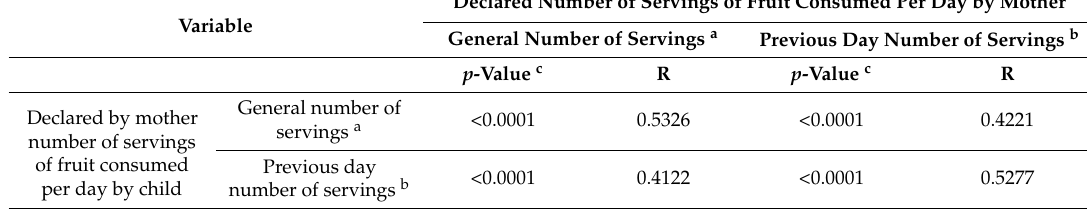
Table 7. Analysis of the correlation between the number of servings of fruit consumed per day by mothers, and their declared consumption by their children in a national sample of Polish respondents ( n = 1200).